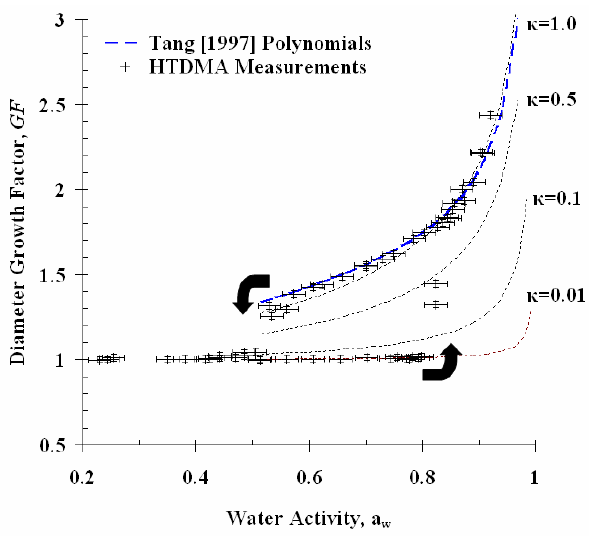
Figure 3. Comparison of HTDMA-measured growth curves with theory for pure KCl particles with D d = 100 nm. Both deliquescence and efflorescence branches were measured, as shown by the heavy black arrows. Estimated uncertainties in the measurements are shown as error bars. Predicted GF(RH) curves for various assumed values of the hygroscopicity parameter, κ , are also shown.